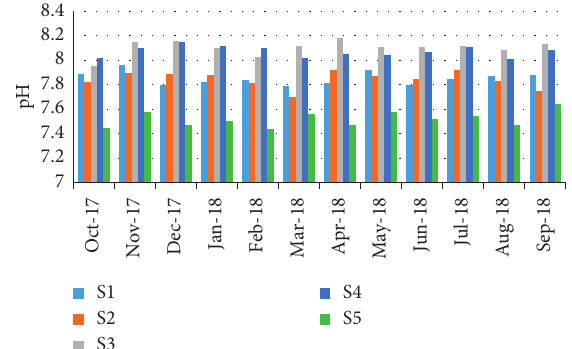
Figure 5: Spatial-temporal variation of pH in the Zegzel watercourse.